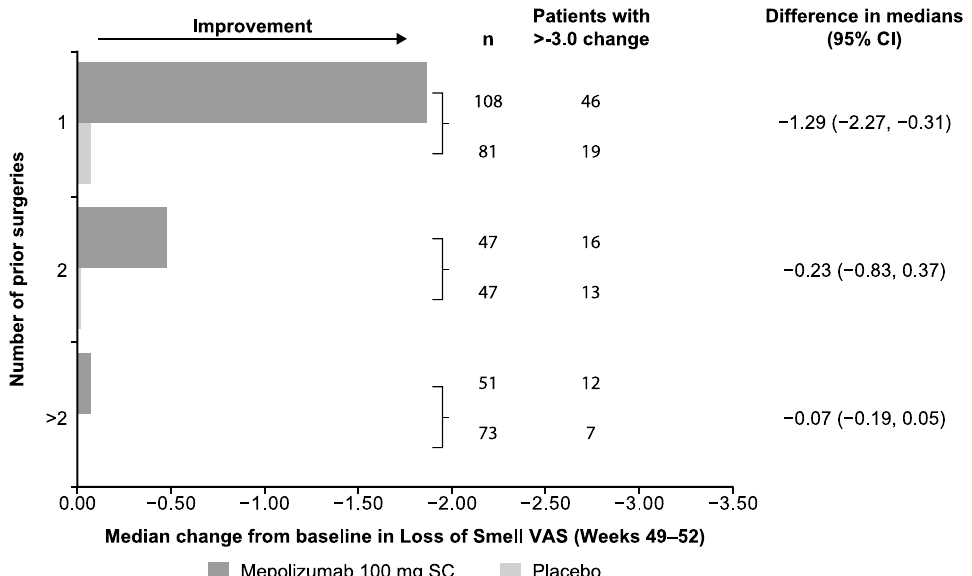
Fig. 6 Change from baseline in loss of sense of smell VAS score by surgery number. CI Confidence interval, SC Subcutaneous, VAS visual analogue scale